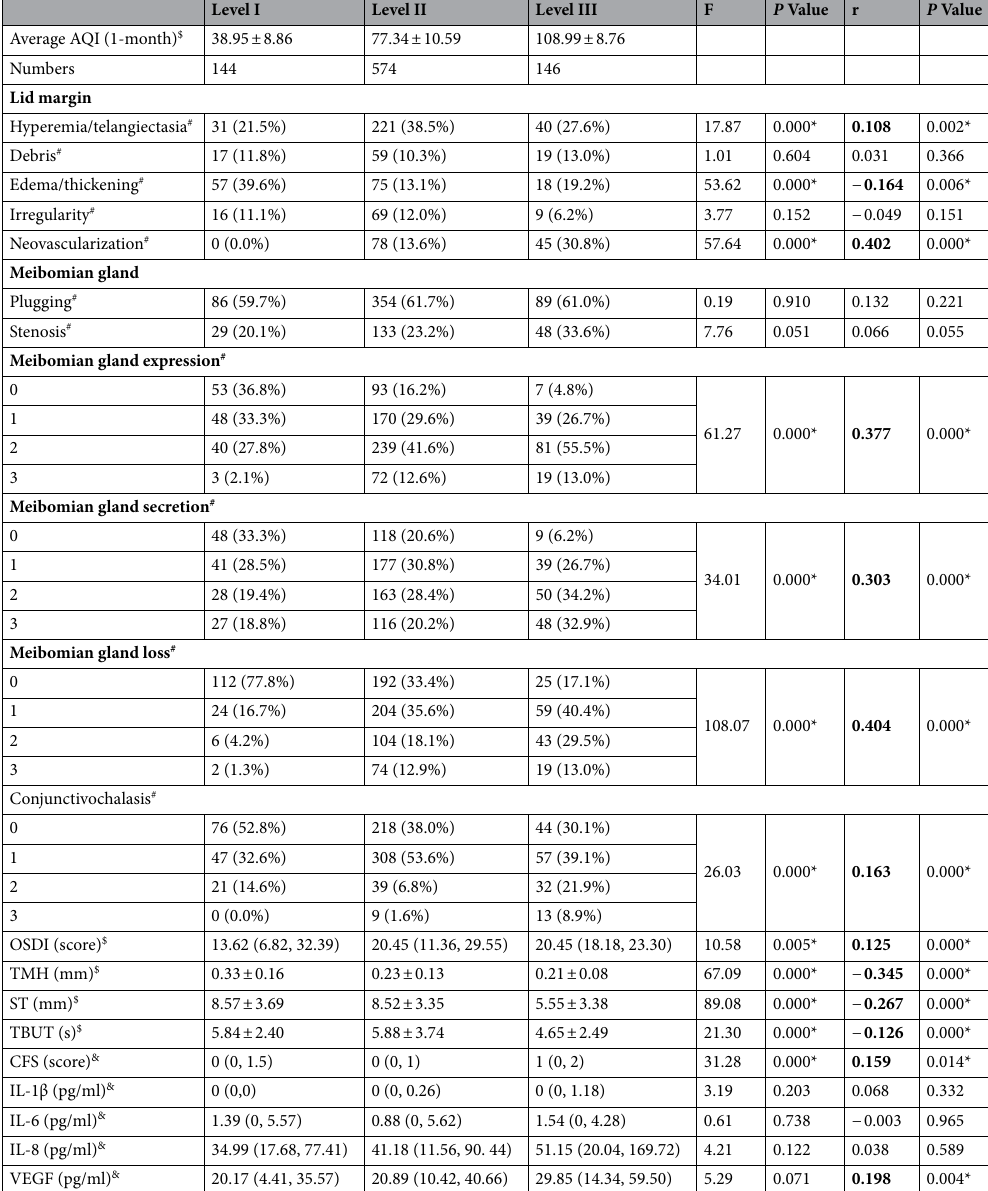
Table 5. Correlations between the ocular surface status and air quality index (AQI) during long-term exposure. OSDI ocular surface disease index, TBUT tear film break-up time, ST Schirmer’s I test, CFS corneal fluorescein staining, TMH tear meniscus height, IL-1β interleukin 1 beta, IL-6 interleukin 6, IL-8 interleukin 8, VEGF vascular endothelial growth factor. # Crosstab analyses were compared and results were expressed as number (percentage); $ Kruskal–Wallis tests were compared among three groups, independent t tests between two groups and results were shown as mean ± standard deviation (SD); & Kruskal–Wallis tests were compared among three groups, Mann–Whitney nonparametric U tests between two groups and results were shown as median (25% quantile, 75% quantile); Spearman correlation analysis was conducted to assess the associations between different atmospheric environments, various indices of ocular surface, and cytokine levels. * P <